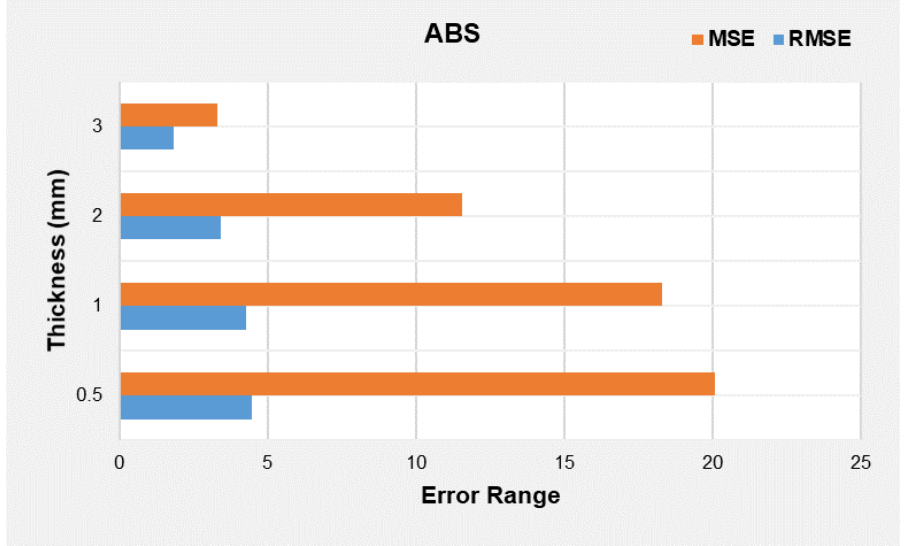
Figure 19. Thickness versus error ranges for MSE and RMSE for ABS beam .